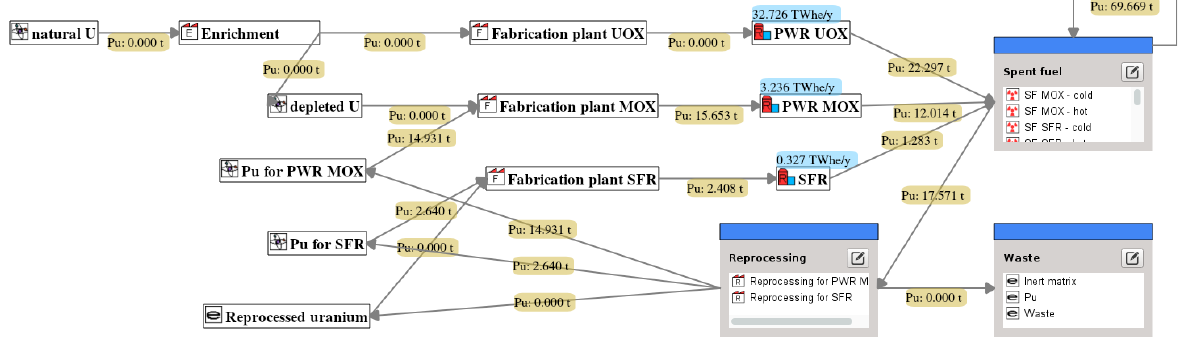
Figure 1. “Fuel cycle” window in the COSI7 decision - maker